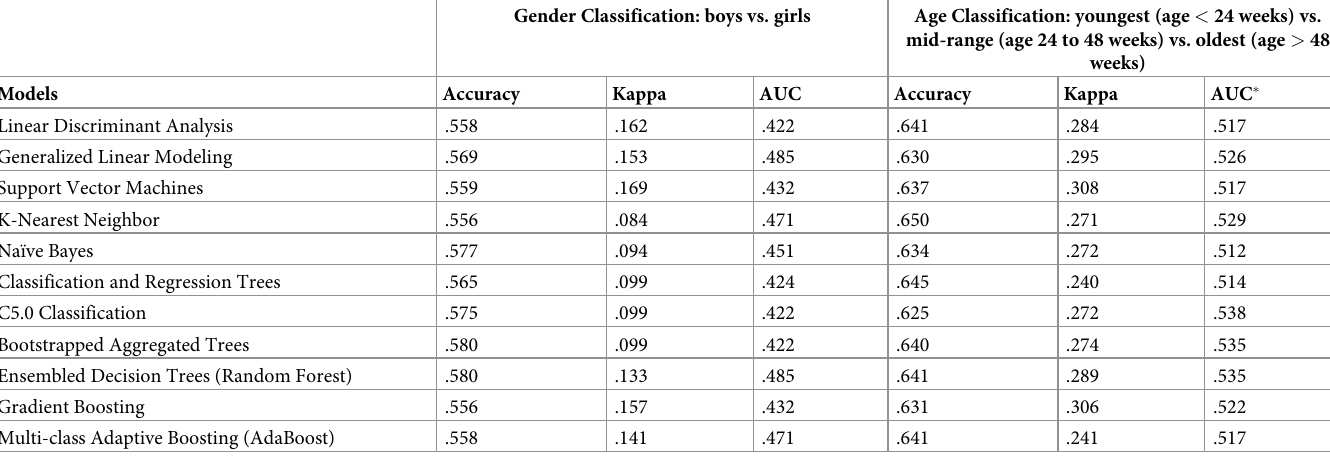
Table 3A. Classification effectiveness indicators across machine learning algorithms: Gender and age-based classification with temperament features.